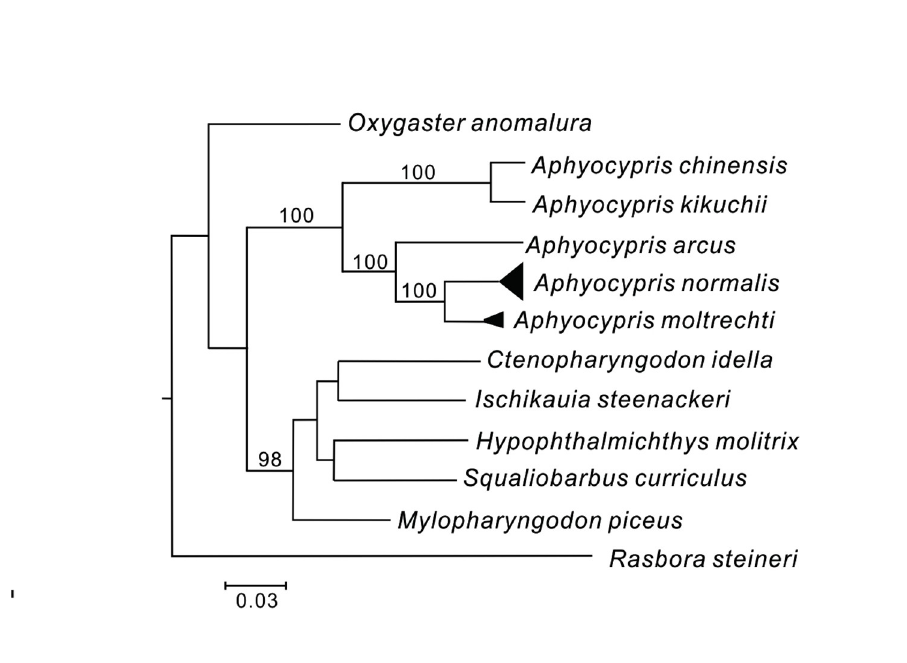
Fig 3. Phylogenetic analysis of Aphyocypris normalis and its closely related species derived by the Bayesian method under the HKY+I+G model. Numbers at internal nodes are Bayesian posterior probabilities and only value > 90% are